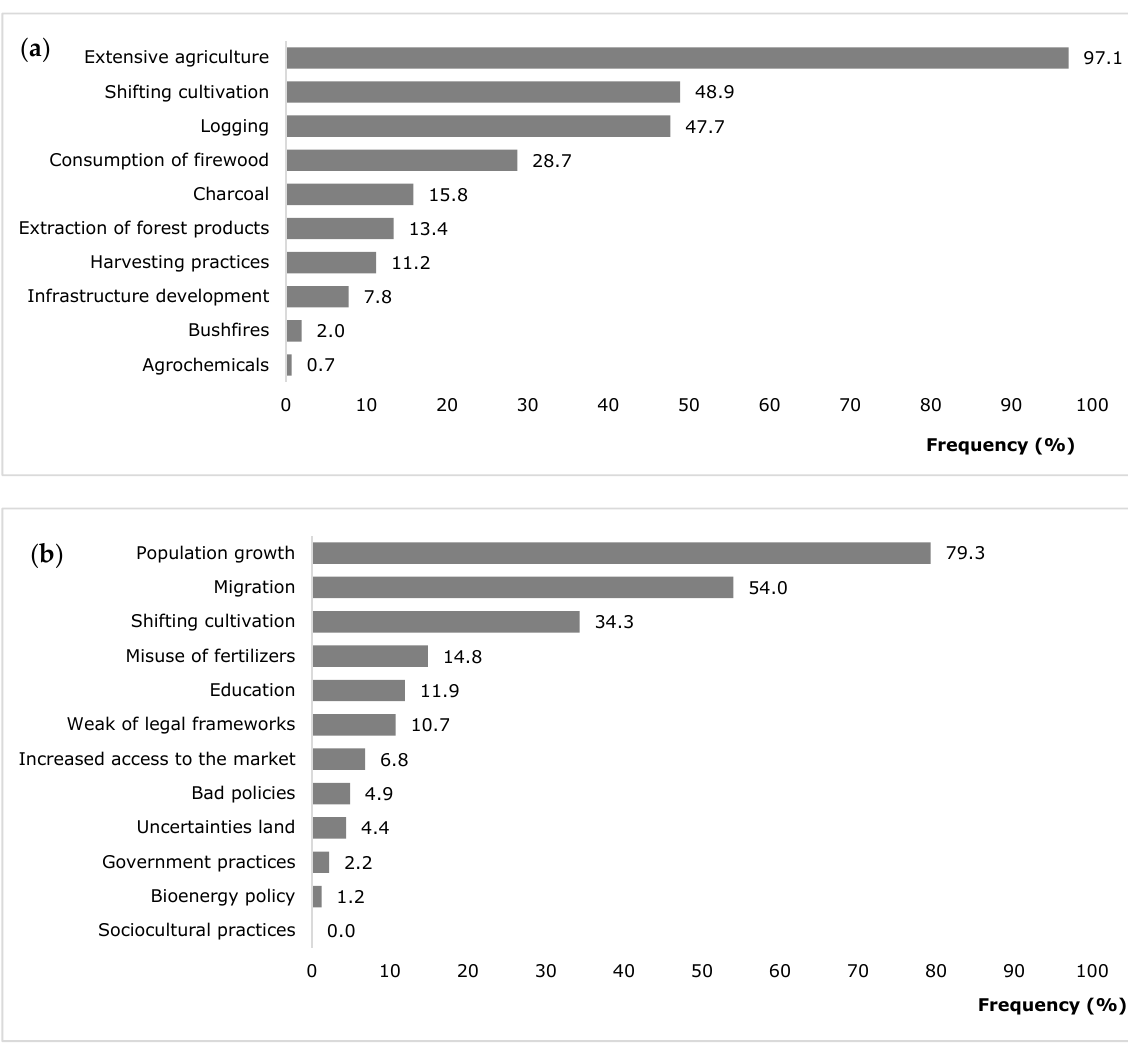
Figure 4. Perceived ( a ) direct and ( b ) indirect causes of deforestation in the study area in south-western Côte d’Ivoire.